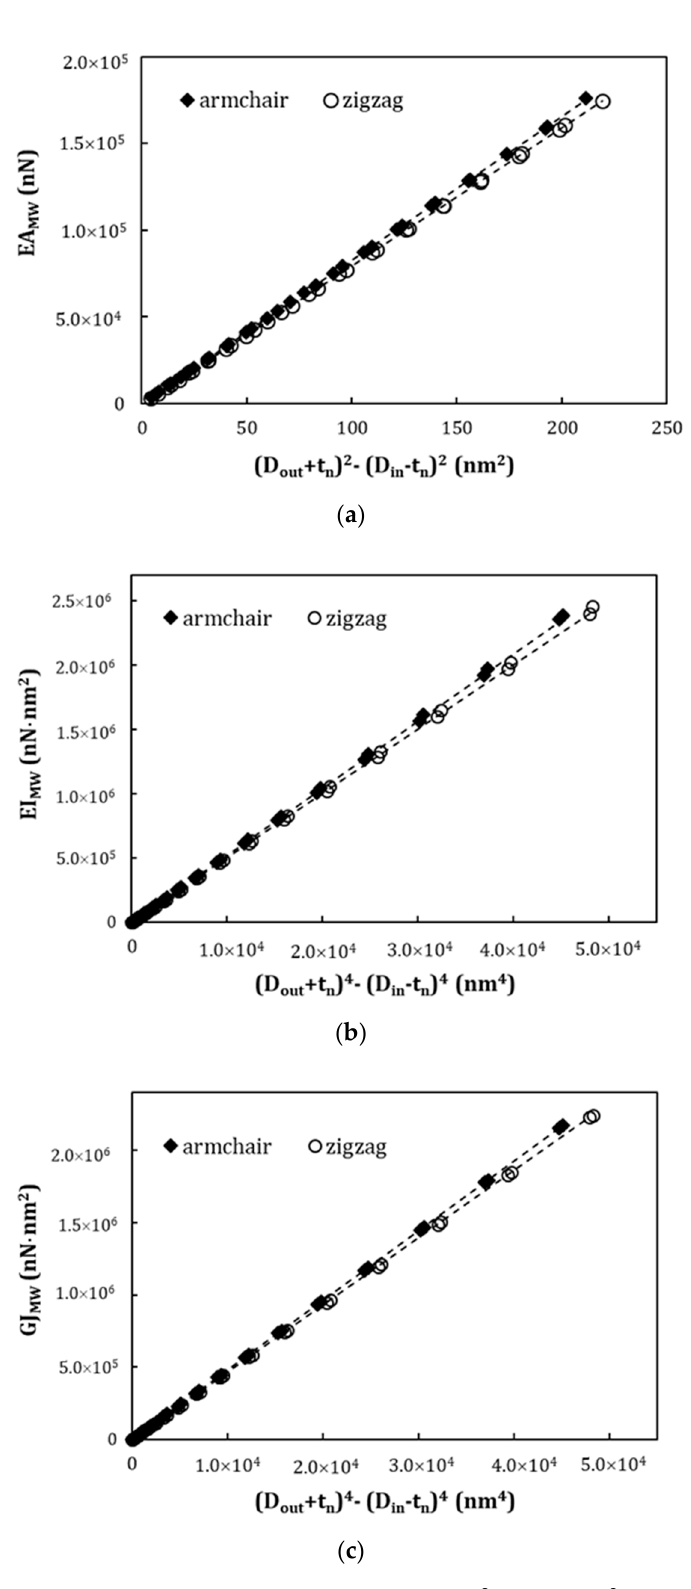
Figure 4. Evolutions of rigidities as a function of: ( a ) ( D out + t n ) 2 − ( D in − t n ) 2 , for the tensile rigidity, EA MW ; ( b ) ( D out + t n ) 4 − ( D in − t n ) 4 for bending rigidity, EI MW ; and ( c ) ( D out + t n ) 4 − ( D in − t n ) 4 for torsional rigidity, GJ SW . The results are represented by symbols and fitting trends by lines.